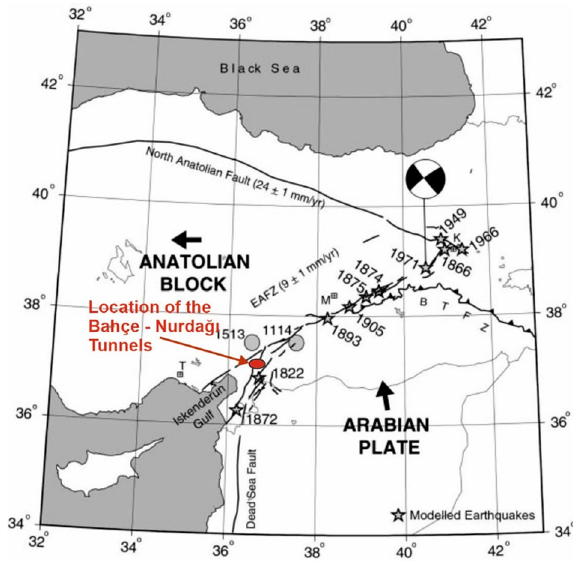
Fig. 2 The Bahçe–Nurdag tunnel location on the seismotectonic map of the East Anatolian Fault Zone (the map was taken